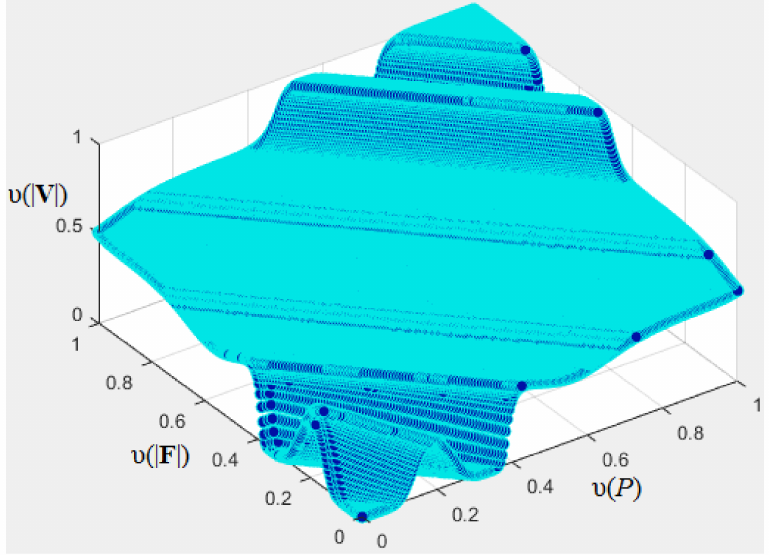
Figure 6. The realgridsurface describes the semantic relationship between | V |, | F | and P based on the MLP network.